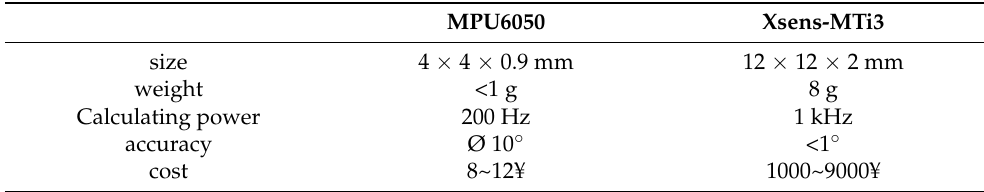
Figure 13. Installation diagram of flight control module. Table 2. Comparison between MPU6050 and Xsens-MTi3.